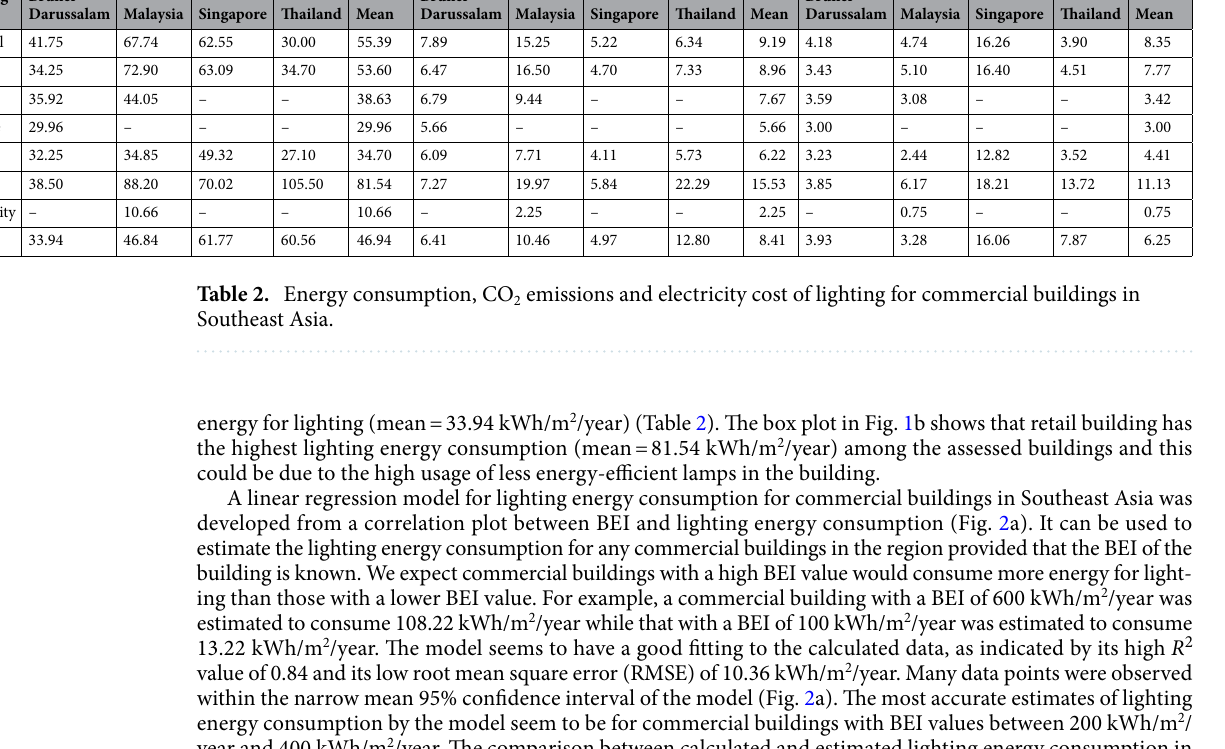
year and 400 kWh/m 2 /year. The comparison between calculated and estimated lighting energy consumption in